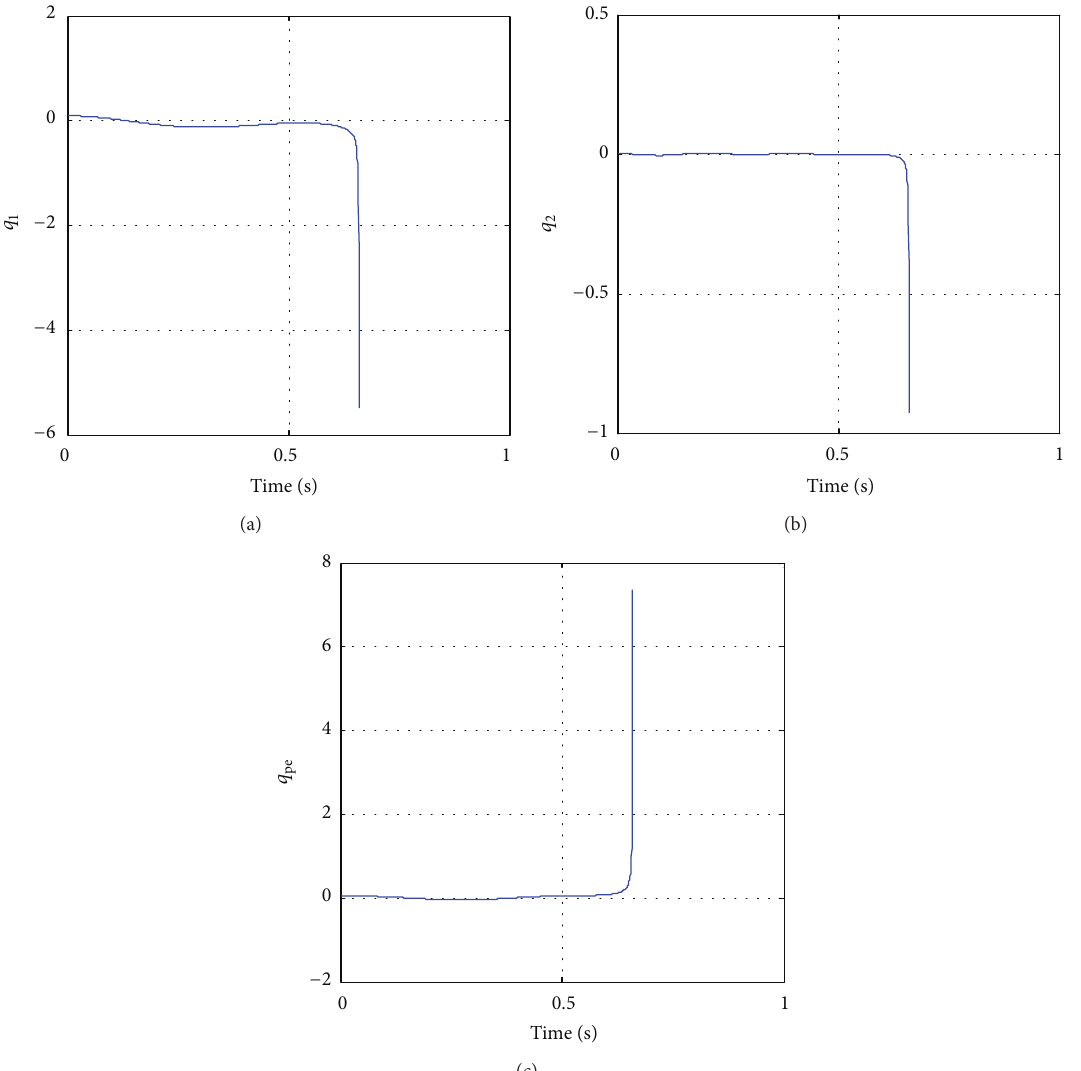
Figure 9: Feedback-linearisation with nonlinear parameter error: response at 80 ms −1